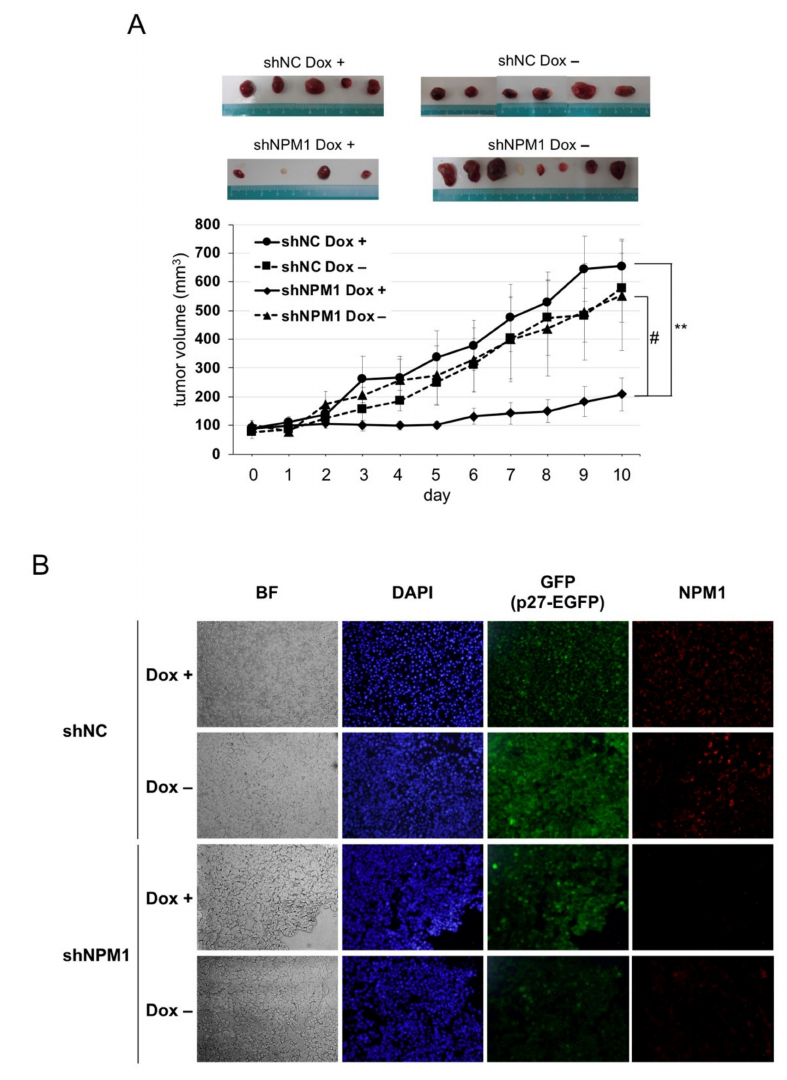
Figure 4. NPM1 suppresses p27 function in mouse xenograft model. ( A ) Control shRNA (NC)- and shNPM1 (No. 2)-introduced HT1080 Tet-on p27-EGFP cells were injected subcutaneously into the back of BALB / c-nu nude mice. One week after injection, mice were fed with Dox (200 µ g / mL) or only solvent and the size of tumor was measured every day. (top) Samples of the tumors excised from four groups of xenografted mice. (bottom) The tumor volume was calculated as follows: volume (mm 3 ) = (length, mm) × (width, mm) 2 × 0.523. ** 0.005 < p < 0.01 and # 0.05 < p < 0.1; ( B ) Immunofluorescence analysis of p27 and NPM1 in tumors. The tumors excised from each group of xenografts were subjected to immunofluorescence analysis using anti-NPM1 antibody (red). Nuclei were stained with DAPI. BF, bright